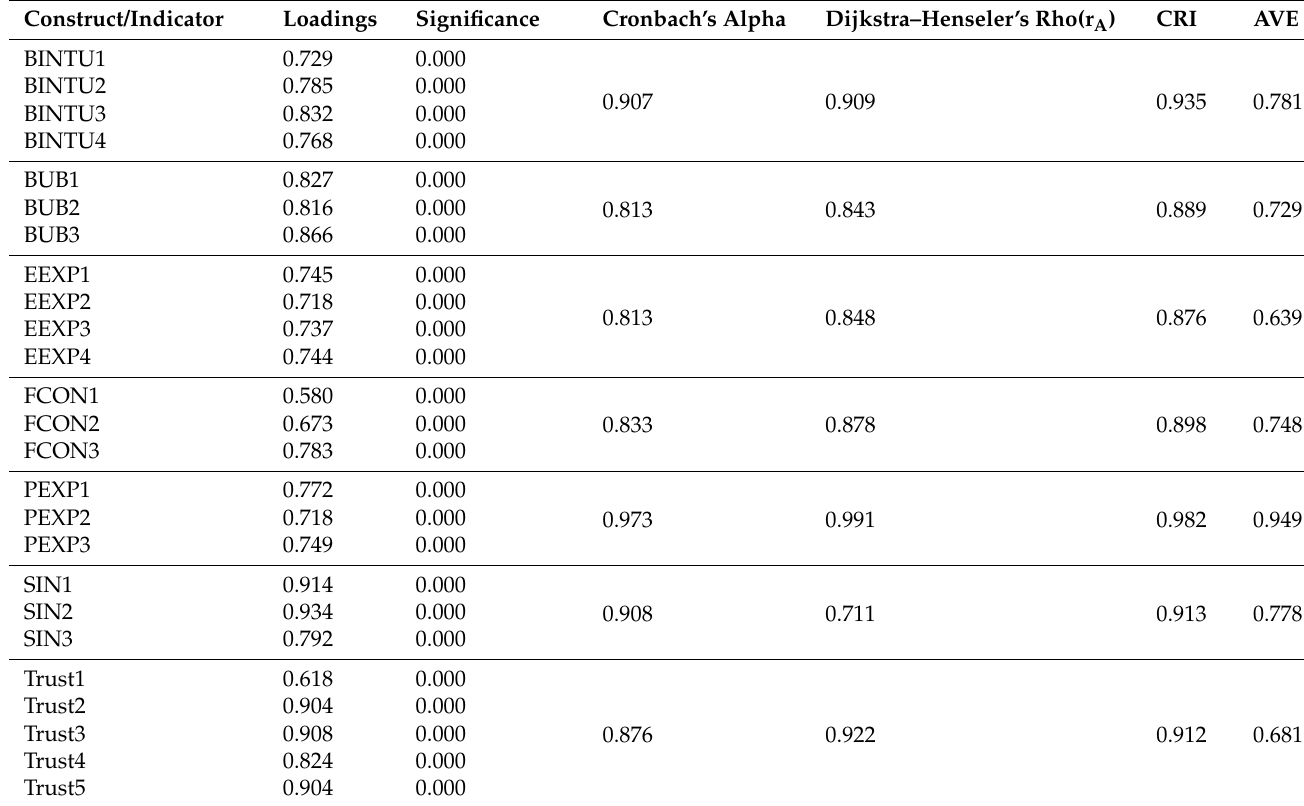
Table 4. Validity and reliability scores.